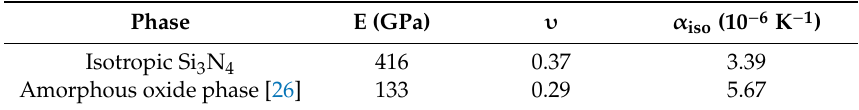
Table 3. Properties of isotropic